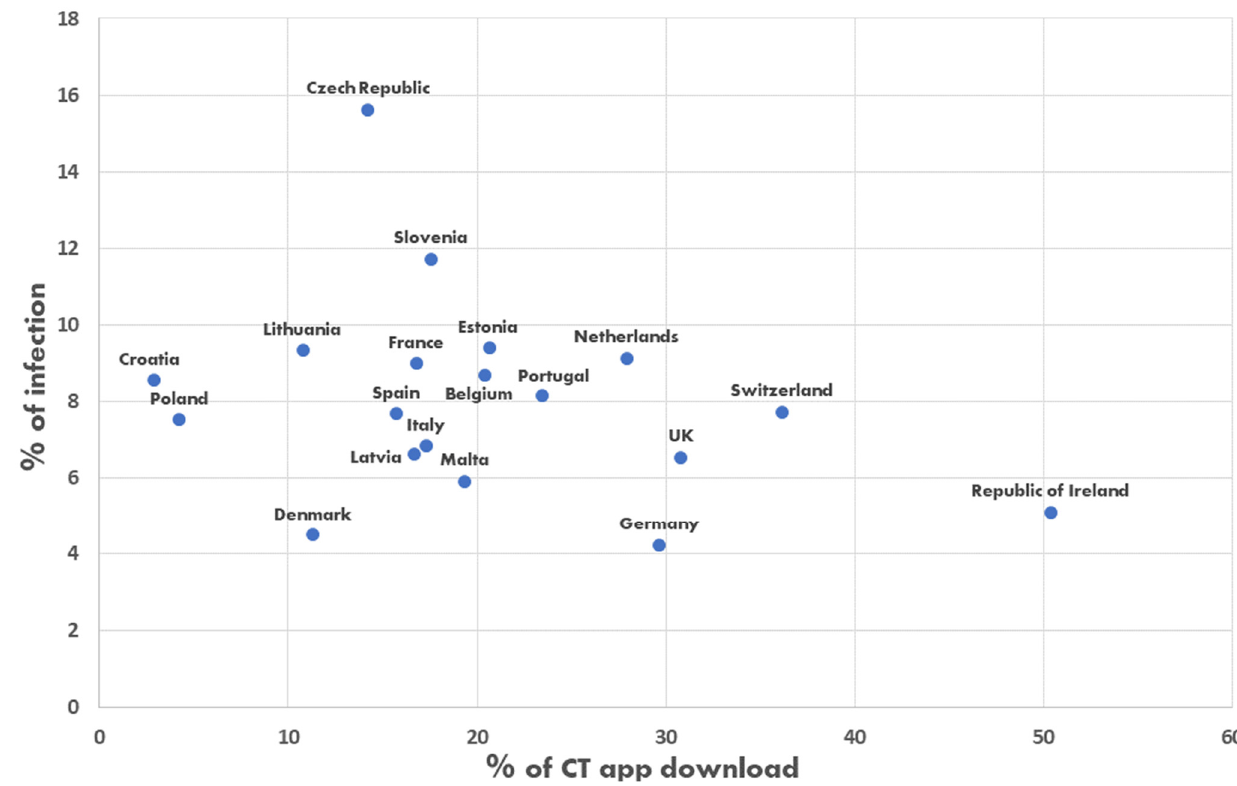
Figure A1. Scatter plot. Relationship between the percentage of people that downloaded the CTSs and the infected population in each of the 19 selected countries.